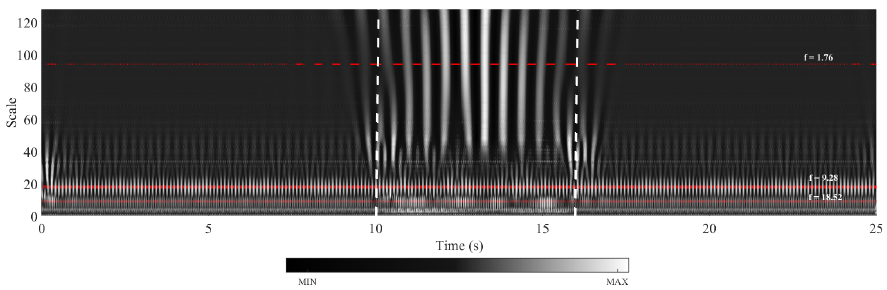
Figure 12. Wavelet coefficient map of the accelerations recorded on the bogie for a speed of 20